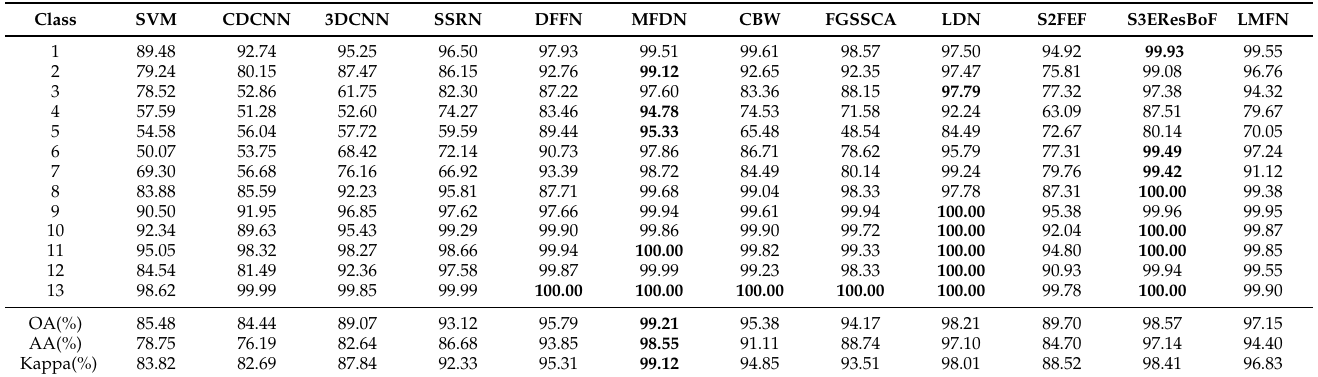
Table 8. Performance comparison with state-of-the-art methods, in terms of classification accuracy, for the KSC data set.The best results are highlighted in bold